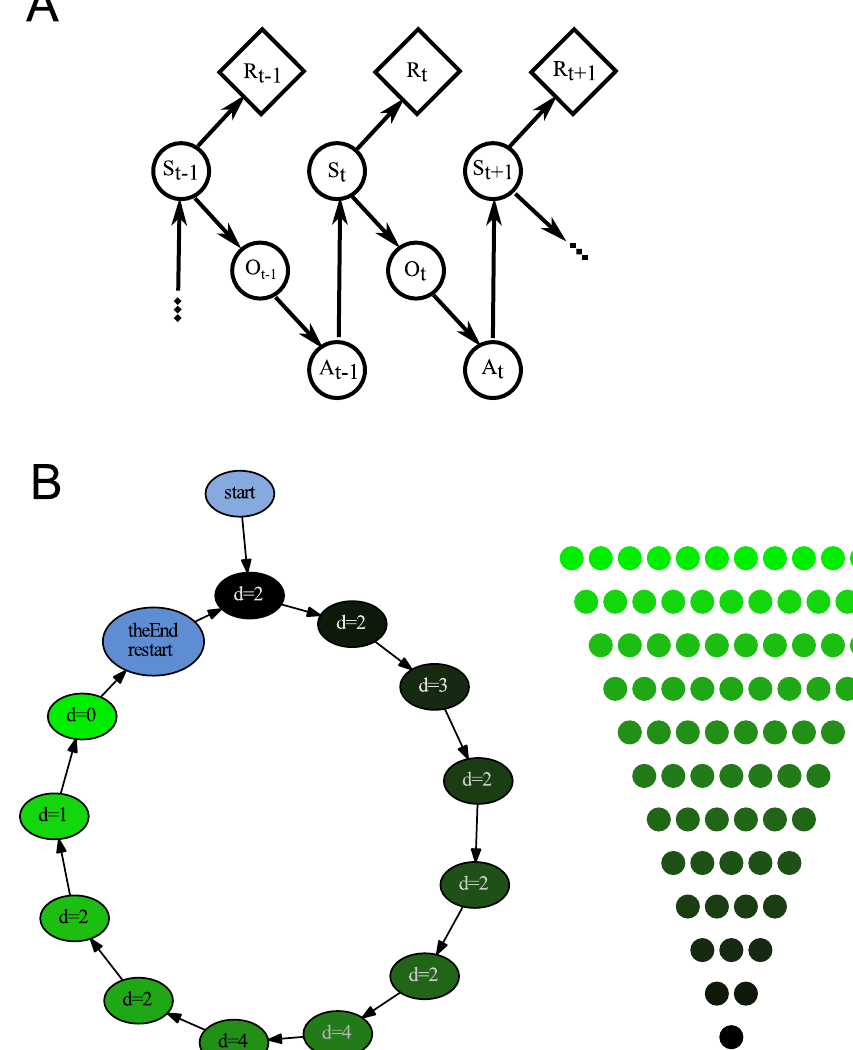
Fig 12. Partially observable Markov decision process (POMDP). (A) Elements of POMDP. Upon entering state S t the actor receives reward R t and observation O t . The observations are used to select action A t that results in moving to state S t + 1 . This iterative process repeats for multiple stimuli. (B) Results of a POMDP simulation. The nodes on the circular policy graph represent stimulus rows. At each node, the simulated actor chooses to look ahead for some distance d and translates the maximum score differential to the probability of stepping left or right. The simulated actor makes 11 such choices (for the 12 rows of the stimulus) and then starts the next trial using a stimulus randomly chosen (with uniform probability) from the set of all